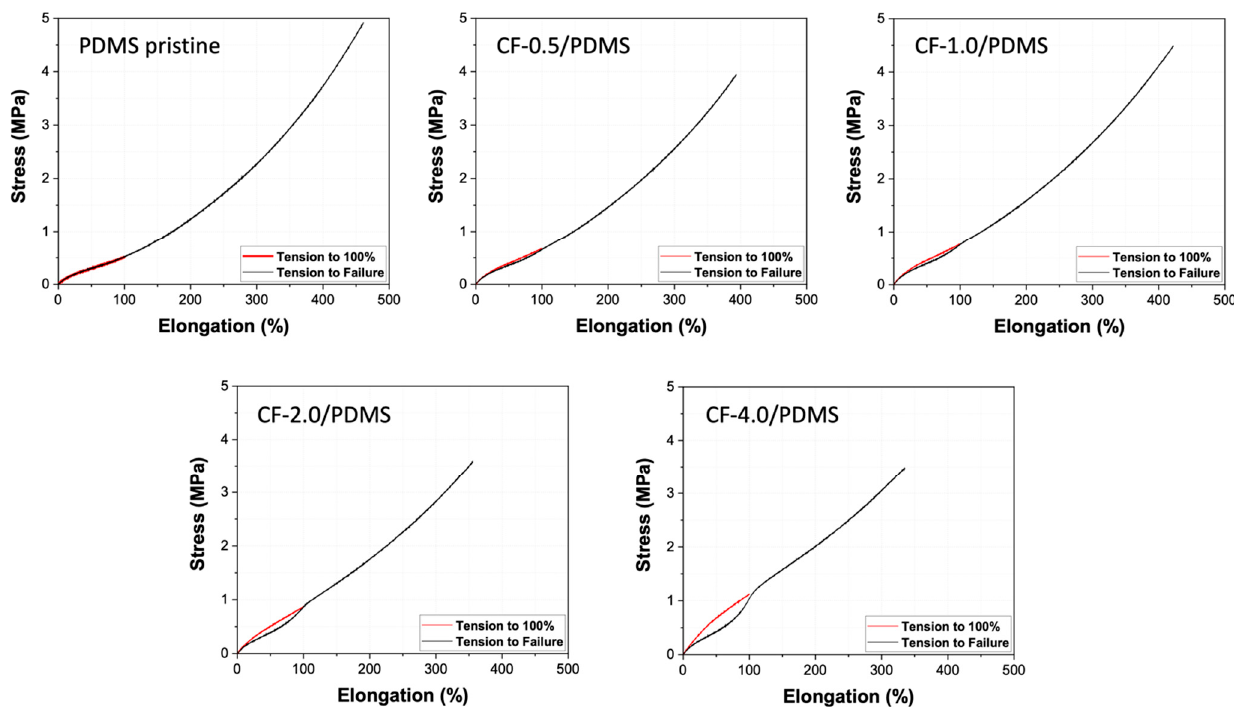
Figure 4. Stress-strain curves as a function of CF filler amount in PDMS matrix. Red curves show initial tension from 0% to 100%, and black curves show subsequent tension on the samples previously elongated to 100% until failure.